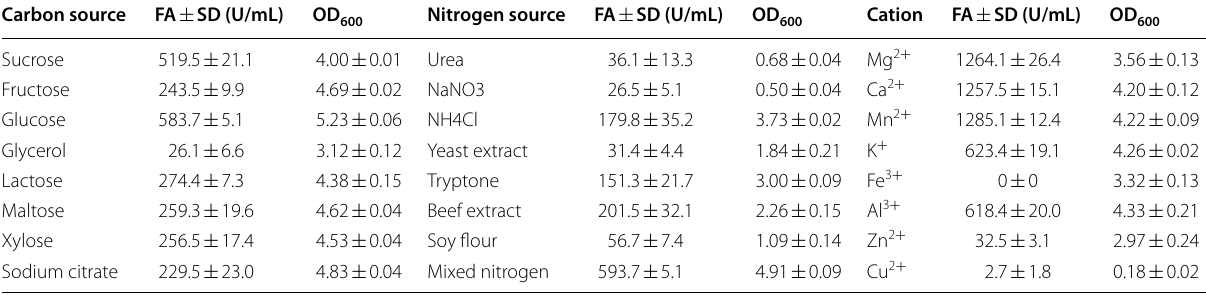
FA: flocculating activity, SD: standard deviation, mixed nitrogen: [yeast extract